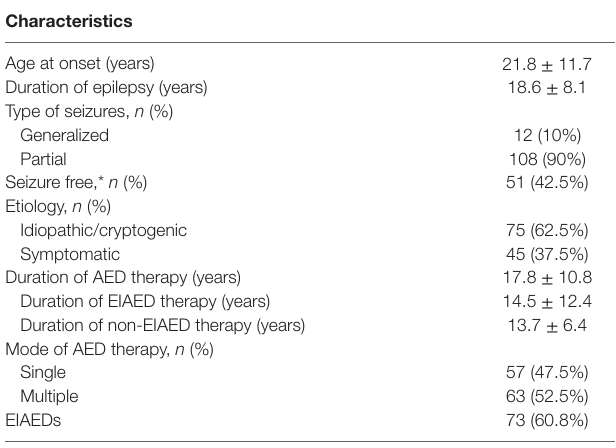
TaBle 1 | Baseline characteristics of 120 patients with epilepsy enrolled in this study.